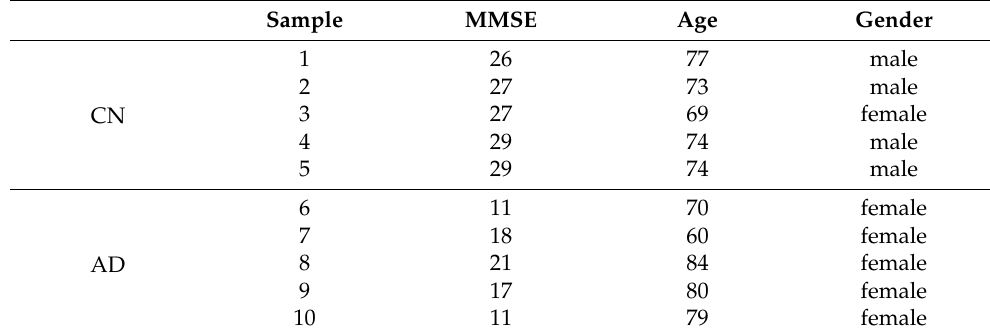
Table 2. Audio information of local Chinese